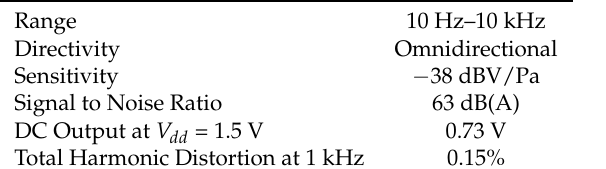
Table 1. Technical specifications of the SPU1410LR5H-QB microphone.